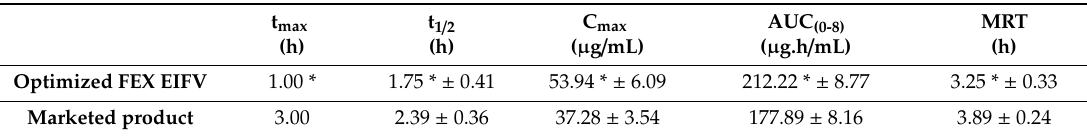
Figure 7. Blood concentration–time profile of FEX after oral administration of the optimized FEX EIFV powder and Telfast ® powdered tablet to rabbit (mean ± SD, n = 6). Table 6. Pharmacokinetic data from the curve fitting of in vivo rabbit plasma data after administration of the optimized formulation and the marketed products ( n = 6) with SD.